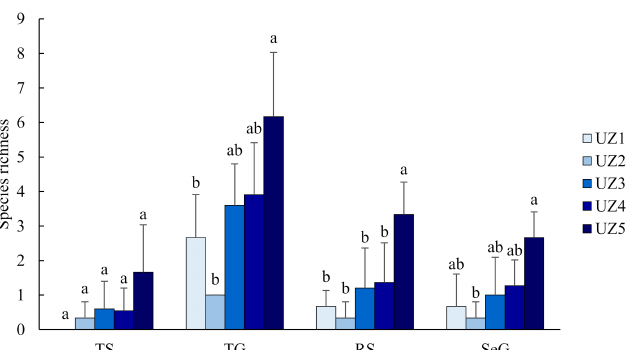
Figure A1. Changes of butterfly species richness in different groups along the urbanisation gradient (UZ1, urban centre; UZ5, urban fringe). Different letters above the bars indicate significant differences at p <